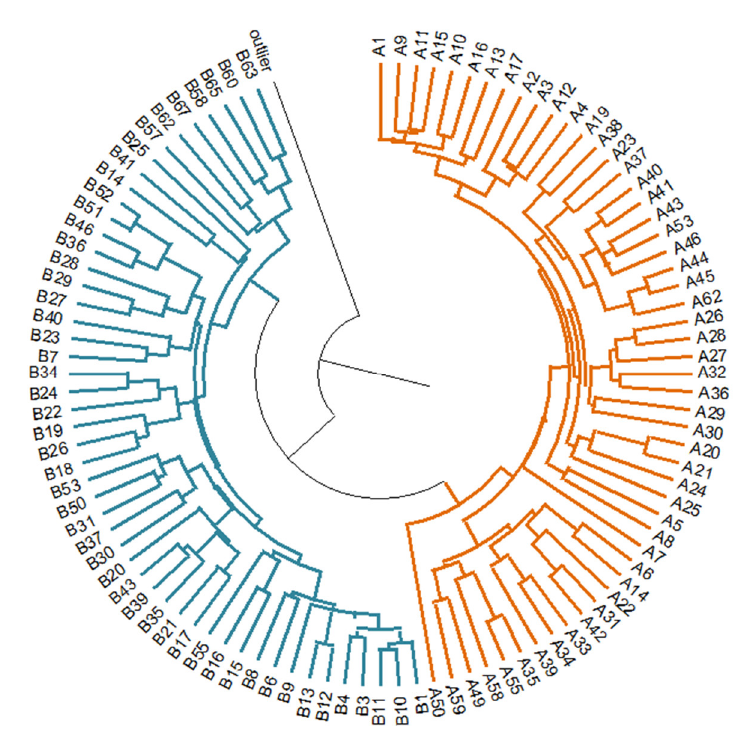
Figure 4. Dendrogram showing genetic relationships of 103 Nitraria accessions based on ISSR data (in orange— Pâclele Mari individuals, in blue— Pâclele Mici individuals, black line—outlier N. komarovii ).